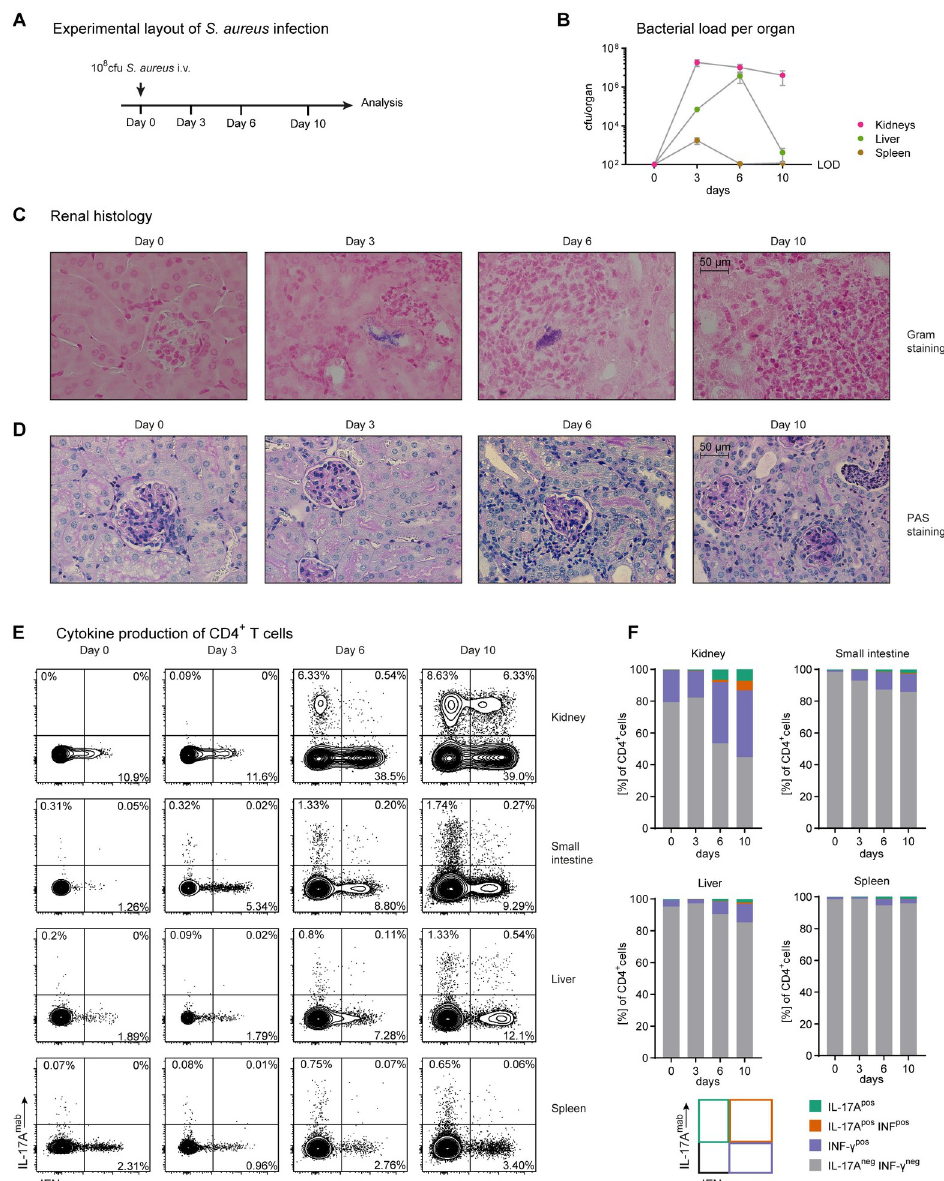
Fig 1. Tissue-specific Th17 cell response in S . aureus sepsis. (A) Model of S . aureus infection: injection of 10 8 cfu into tail vein at day 0 and analysis at indicated time points. (B) Quantification of bacterial load in different organs during S . aureus infection at indicated time points. (C) Gram staining (D) PAS staining of kidney sections after S . aureus infection as indicated. (E) Flow cytometry and quantification (F) of IL-17A and IFN- γ producing CD4 + T cells in different organs after S . aureus infection as indicated (each time point represents the data of n = 3–4 mice, representative data from one of two independent